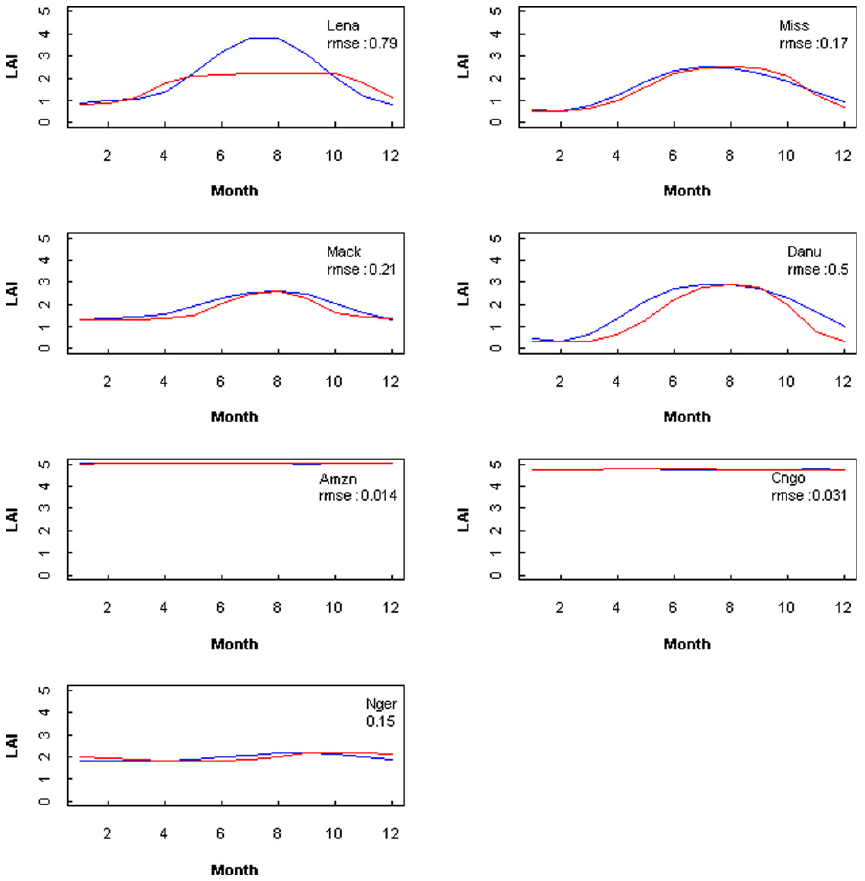
Fig. 7. Modelled (red, LAI) and observed (blue, NDVI) phenology from the 7 river catchments (Lena, Miss: Mississippi, Mack: Mackenzie, Danu: Danube, Amzn: Amazon, Cngo: Congo,